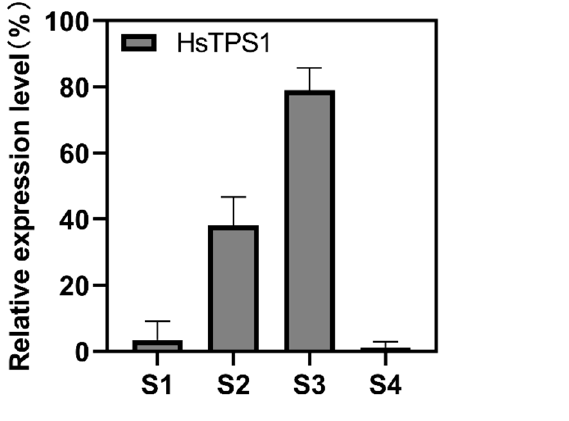
1 Retention time (RT) in min. 2 Relative peak area expressed as percentage of the peak area of corre- sponding compound over the total peak areas of all identified volatiles. ——, not detected. The rel- ative contents of five major terpenoids were labeled in light gray.